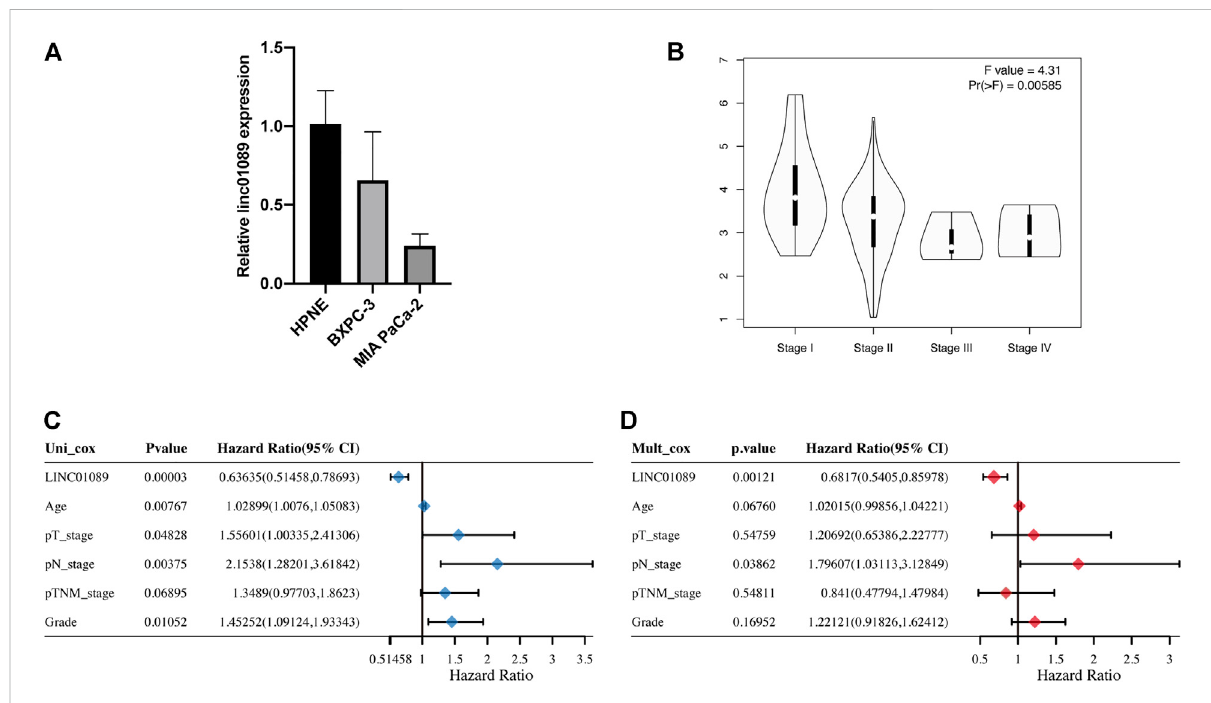
FIGURE 7 Validationoftheexpressionandclinicalcharacteristicsoflinc01089inPAAD. (A) Expressionoflinc01089wasdownregulatedinPAADcellsthan that in HPNE. (B) Correlation between linc01089 and the pathology stage in PAAD. (C,D) Univariate and multivariate analyses indicated that linc01089 and N stage were independent prognostic factors affecting the OS of PAAD